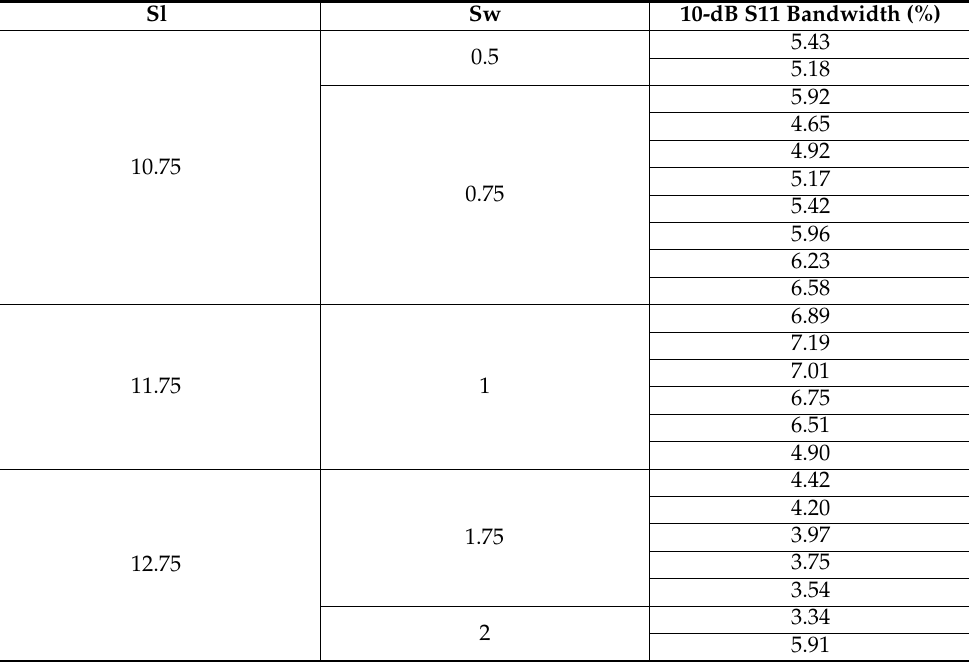
Table 2. Optimisation of the single-strip measurements in mm.